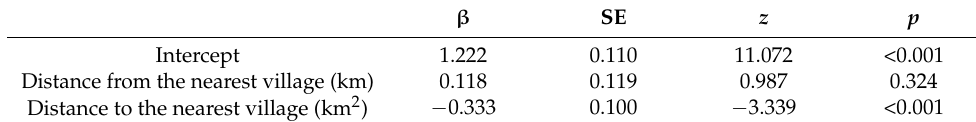
Table 3. Factors influencing the number of Olea europaea (Wall. ex G. Don) Cif. stumps in Hugumburda dry Afromontane forest in northern Ethiopia. Also shown are the parameter estimates ( β ) and associated standard errors and z -values for the relationship between the number of Olea europaea stumps and other explanatory variables retained in the final model (Y = 1.222 + 0.118 x – 0.333 x 2 , R 2 = 0.17).